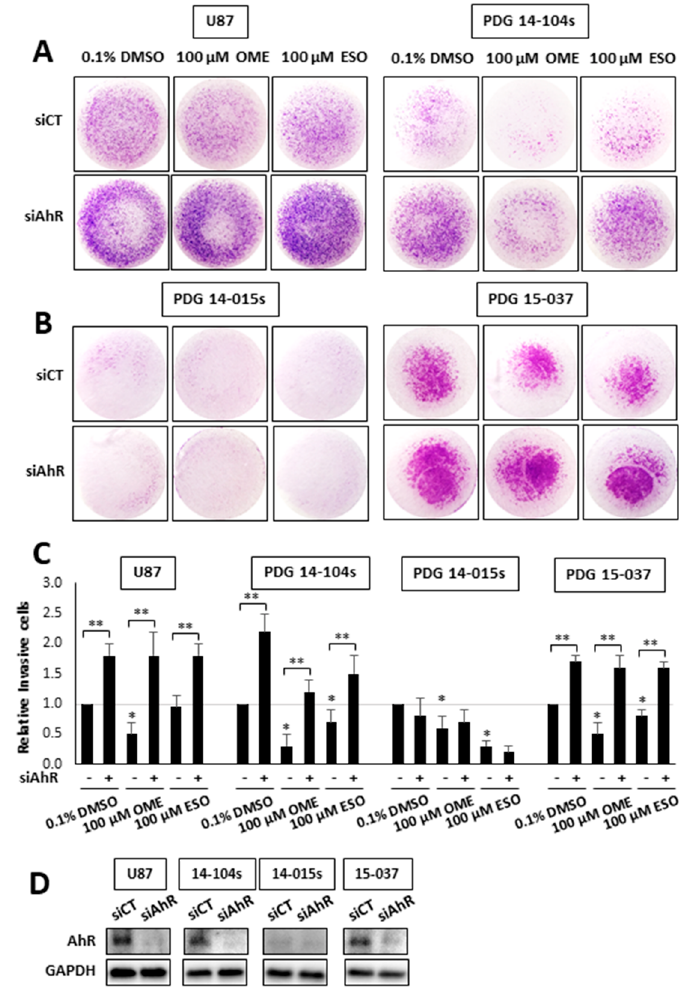
Figure 4. Inhibition of patient-derived GBM cell invasion in the Boyden chamber assay. U87 and 14-014s ( A ), 14-015s and 15-037 ( B ) GBM cells were treated cells were treated with DMSO, 100 µM OME, and 100 µM ESO, and invasion of cells in wild-type (AhR +/+ ) and AhR knockdown cells was determined in a Boyden chamber assay and results were quantitated ( C ) as outlined in the Materials and Methods. Results are expressed as means ± SD for at least 3 separate determinations per treatment group and significant ( p < 0.05) inhibition by ESO and OME (*) and reversal of these effects after AhR knockdown (**) are indicated. AhR expression after knockdown by siAhR in established and patient-derived GBM cells was determined by Western blot of whole cell lysates ( D ).